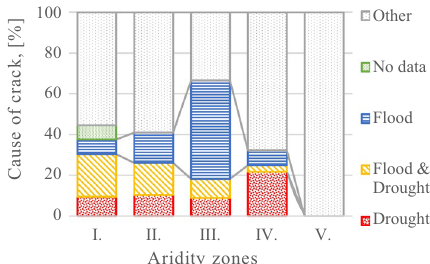
Fig. 14 Aridity zones and causes of cracks